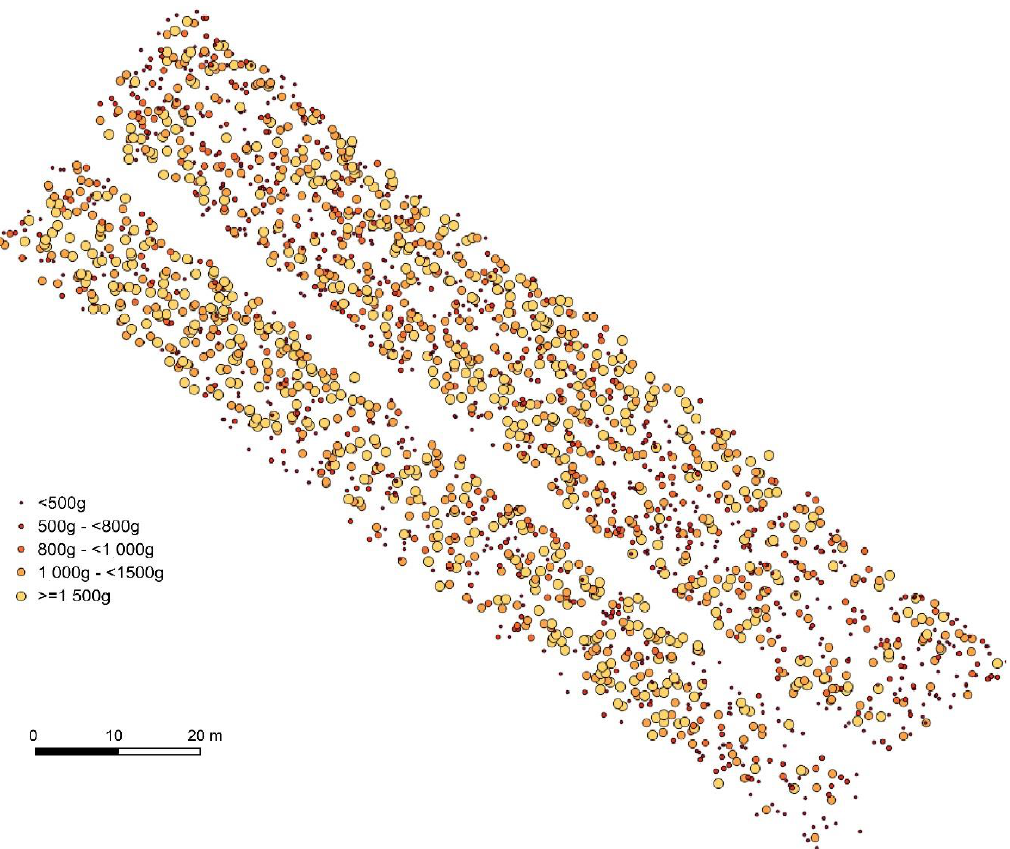
Sensors 2021 , 21 , x Figure 9. Field distribution of pumpkin fruits by weight classes.